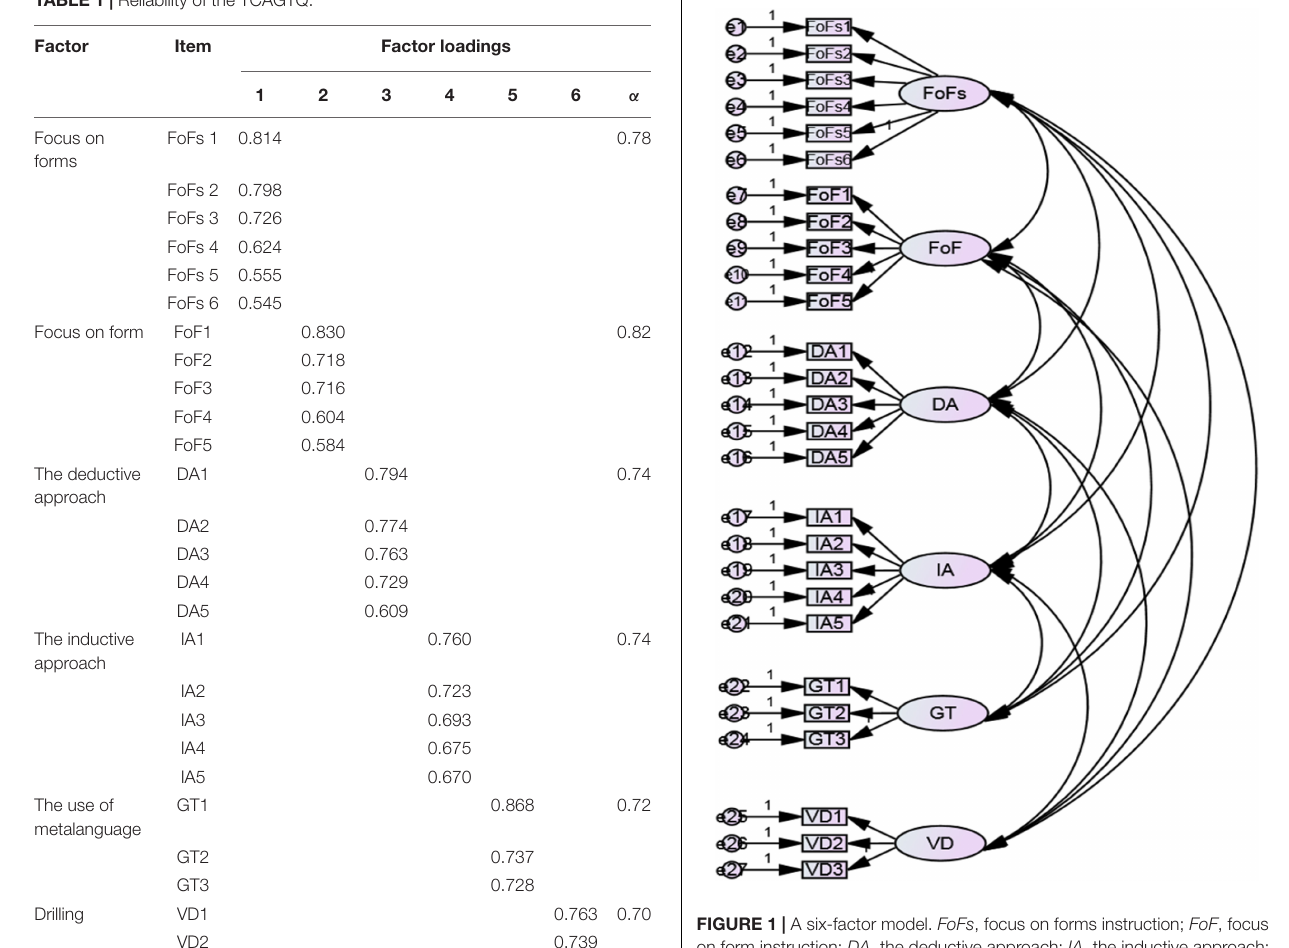
TABLE 1 | Reliability of the TCAGTQ.